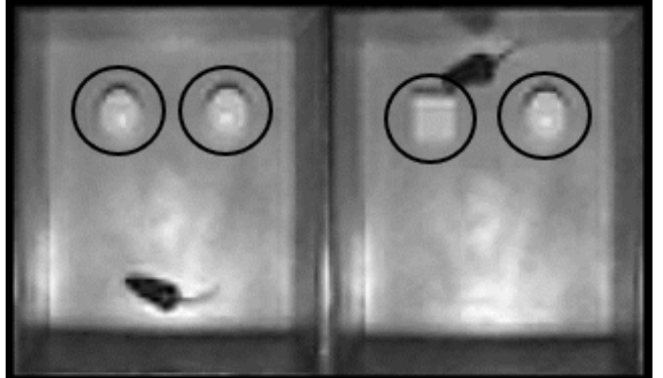
Figure 2. Novel object recognition. The placed objects were 7.5 cm from the side of the walls and 10.5 cm from each other. The region of interest was designated as the area surrounding the object and within 2 cm of the object. The ANY-Maze software measured the total number of nose pokes into the region of interest (ROI) and time spent exploring the objects.